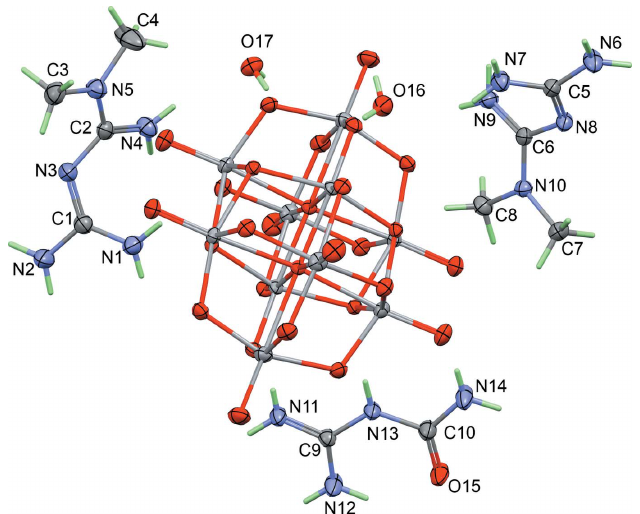
Figure 1 The structures of the molecular entities of the title compound, with displacement ellipsoids drawn at the 40% probability level. The centrosymmetric anion is shown, while the content for cations and water molecules is limited to the asymmetric